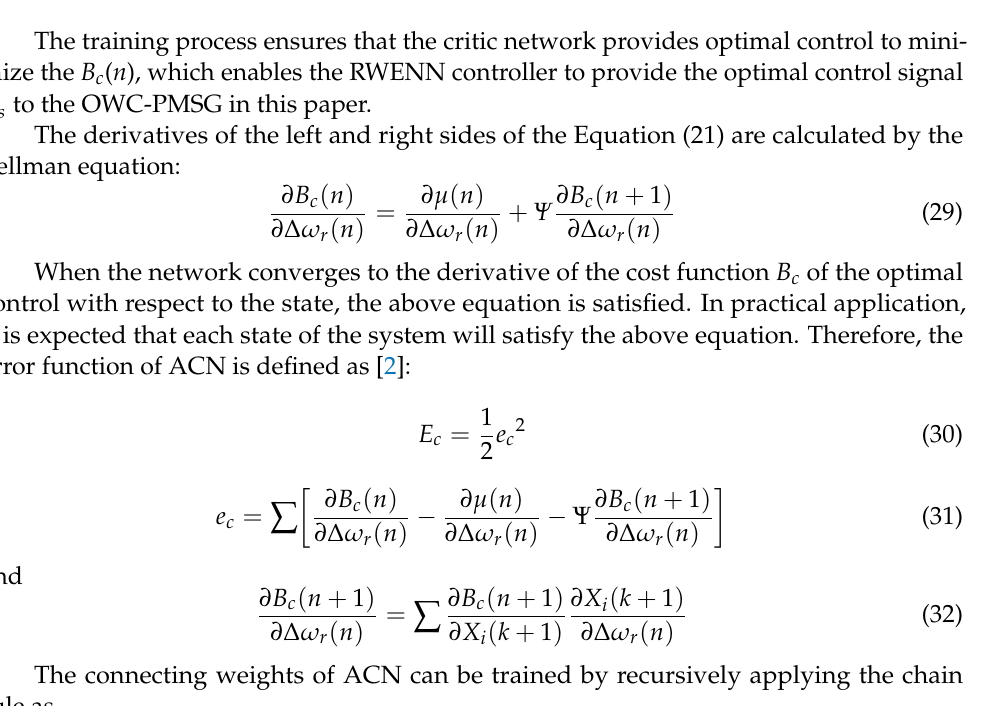
Figure 3. Four-layer ACN structure diagram.